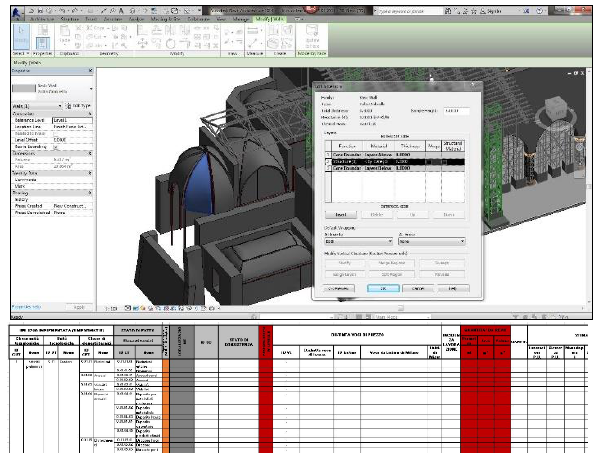
Figure 10. 3D ©Revit model of the building and WBS to manage the restoration.